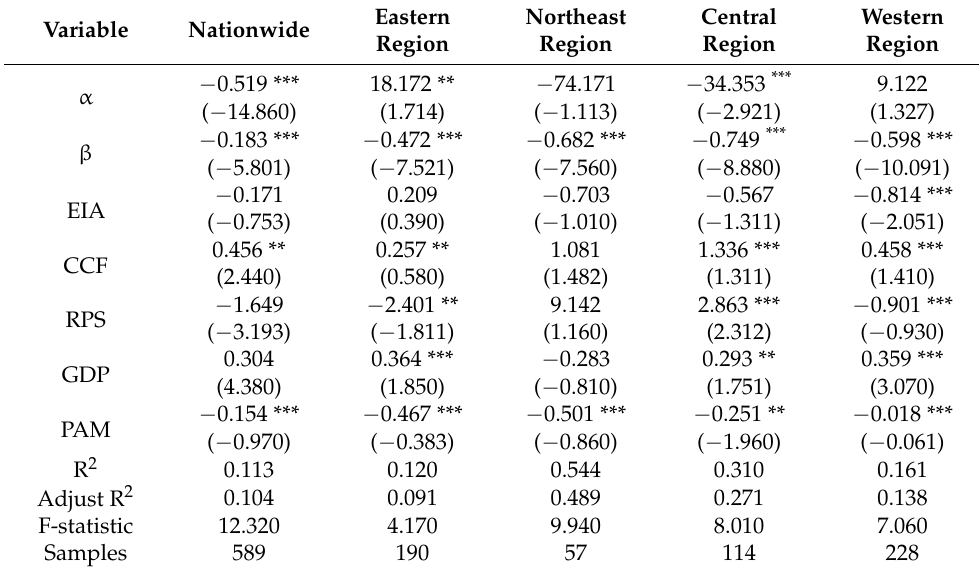
Table 3. Conditional β -convergence results of the flow intensity of virtual cultivated land in study area.